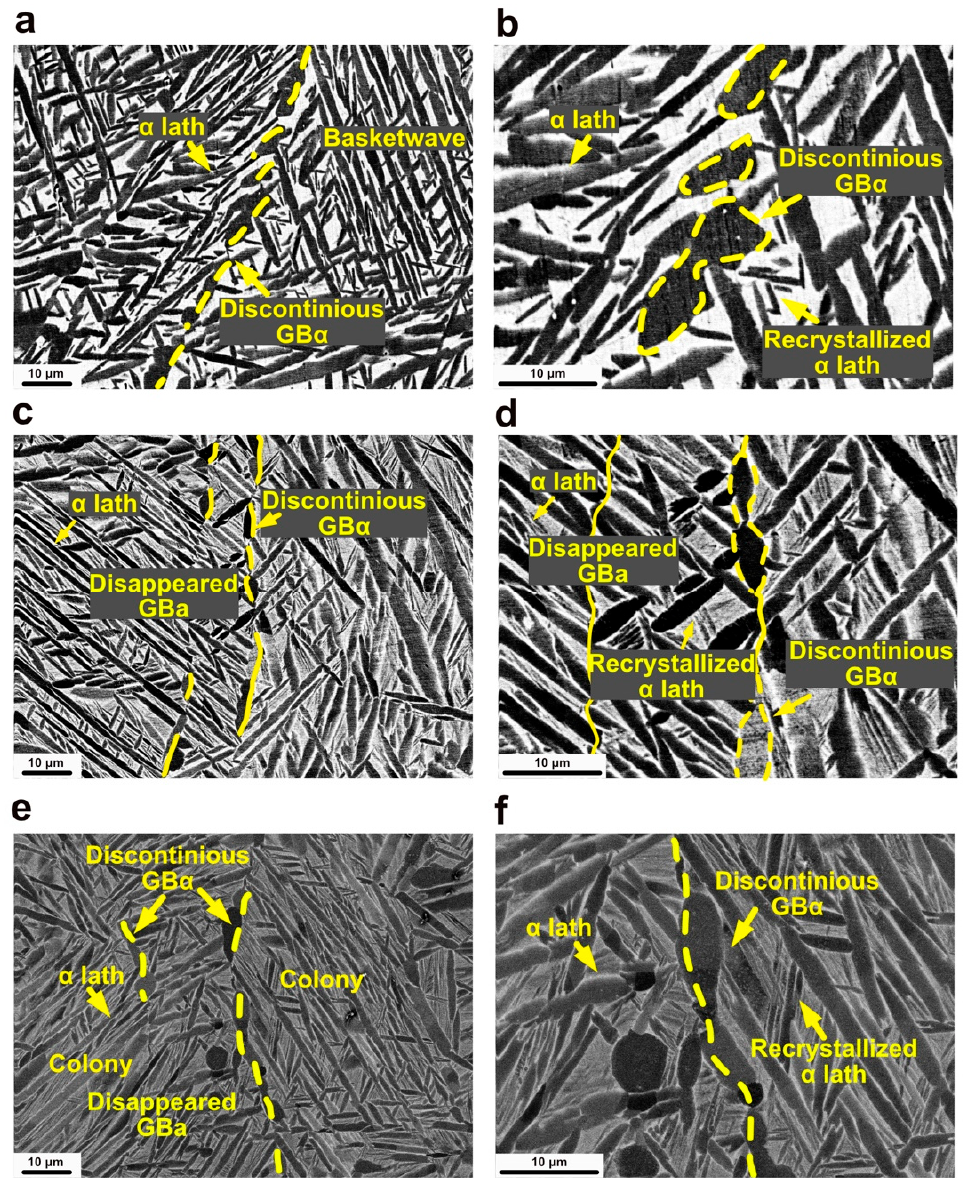
Figure 9. Microstructures in SLMed Ti64 with the different heat treatments, ( a , b ) 950-WQ, ( c , d ) 950- AC, ( e , f ) 950-FC ( c , d ) 950-AC, ( e , f )